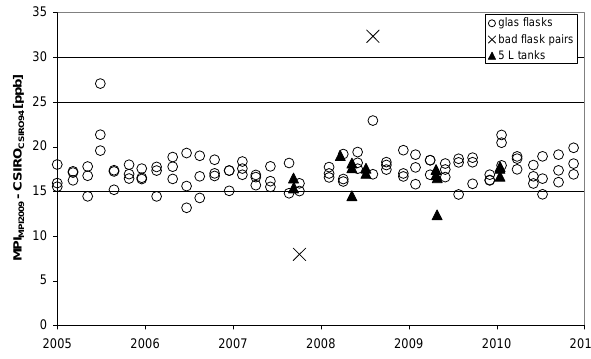
Figure 3. Time series of H 2 intercomparison results between MPI and CSIRO. Circles 2 Fig. 3. Time series of H 2 intercomparison results between MPI represent the differences of the mean results of two flask pairs filled with the same air with 3 and CSIRO. Circles represent the differences of the mean results of each pair being analysed in either laboratory (“Sausage Flask Intercomparison” program, 4 two flask pairs filled with the same air with each pair being anal- ysed in either laboratory (“Sausage Flask Intercomparison” pro- IMECC 2011). Two flask pairs with large pair deviations (>10 ppb) are flagged by crosses. 5 gram, IMECC 2011). Two flask pairs with large pair deviations Triangles correspond to the difference of standard measurements in 5 L high pressure 6 ( > 10ppb) are flagged by crosses. Triangles correspond to the dif- cylinders. 7 ference of standard measurements in 5L high pressure